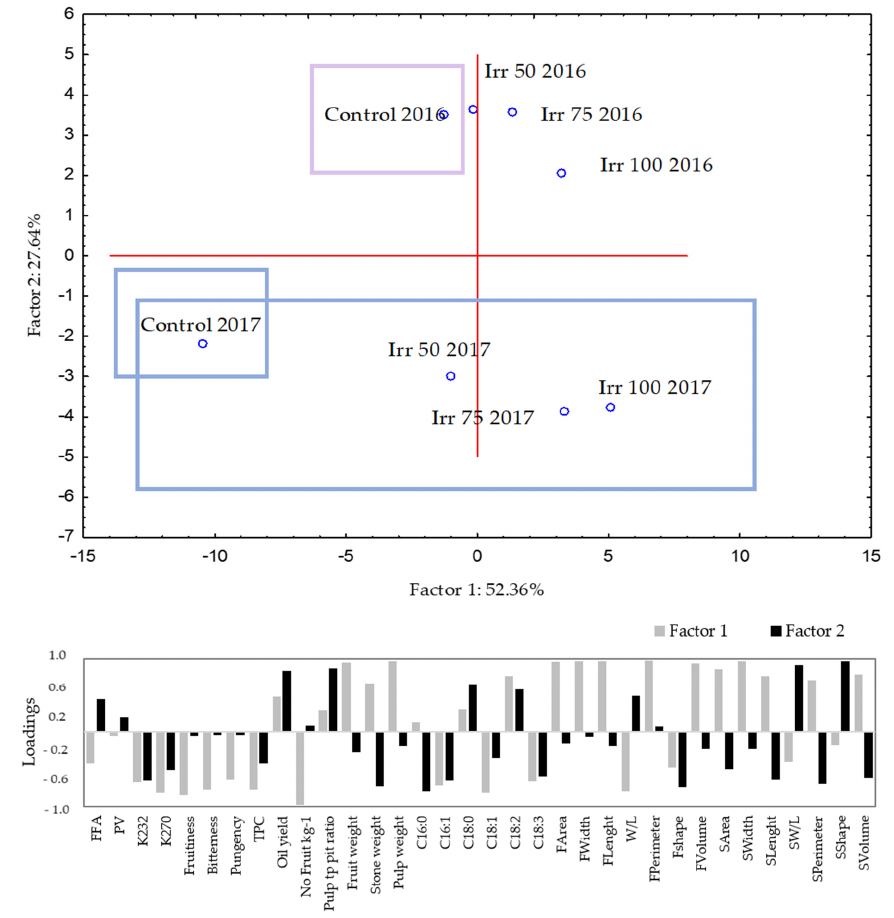
Figure 2. Observation plot of the principal component analysis (PC1 vs. PC2) showing the dispersion of samples on the measured morphological, chemical and sensorial parameters; and the diagram of the loadings for the analyzed